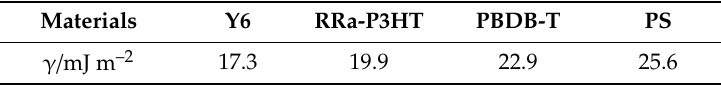
Table 2. Surface energy ( γ ) of materials used in this study.